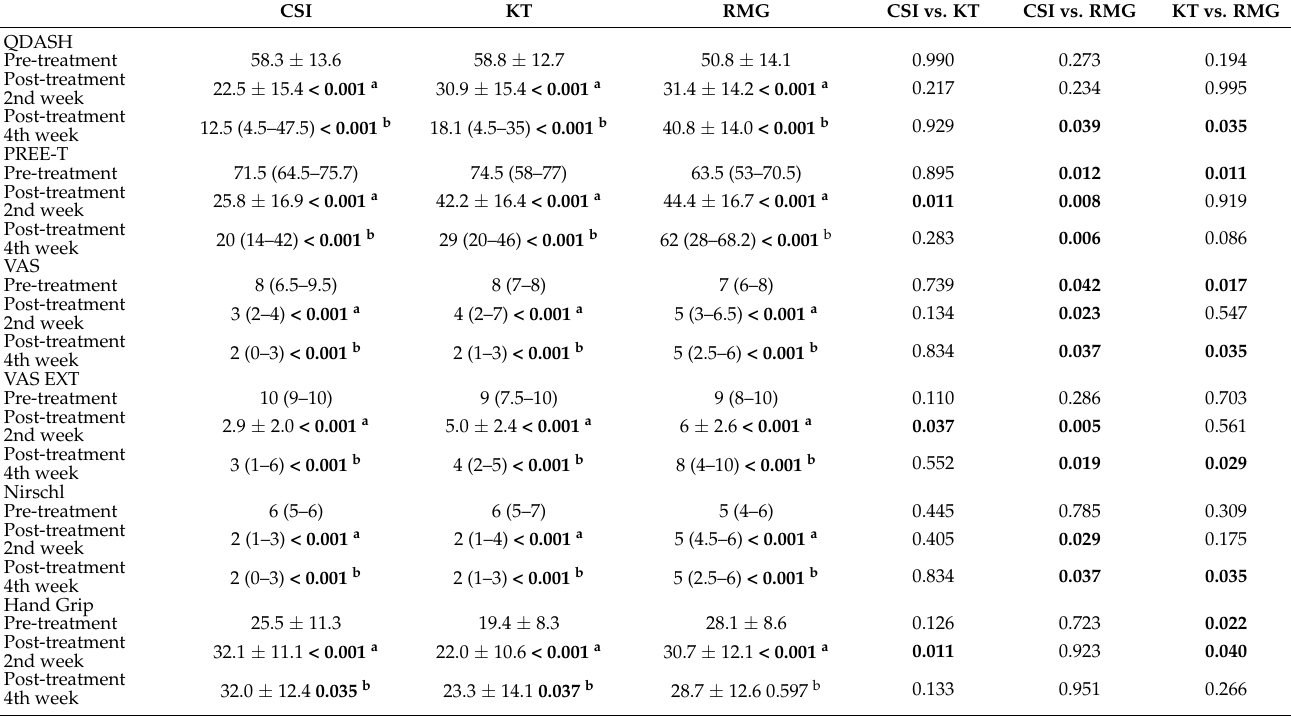
Table 3. Clinical findings and p values of comparisons in repeated measures and between